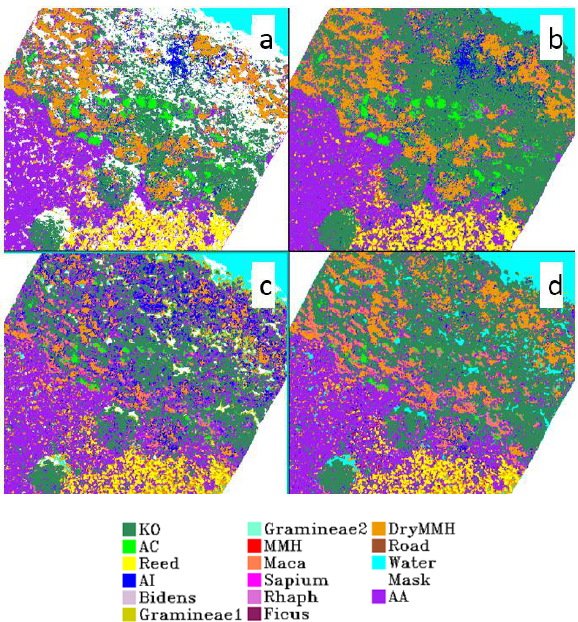
Figure 3. SVM classification map before and after adding